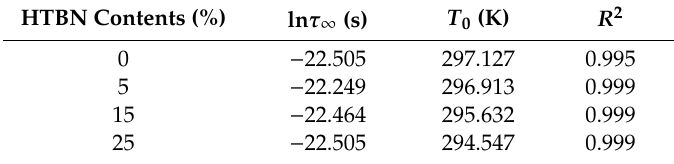
Table 2. Vogel‒Fulcher‒Tammann equation (VFT-equation) fitting results of relaxation time of α Table 2. Vogel-Fulcher-Tammann equation (VFT-equation) fitting results of relaxation time of α relaxation. relaxation.